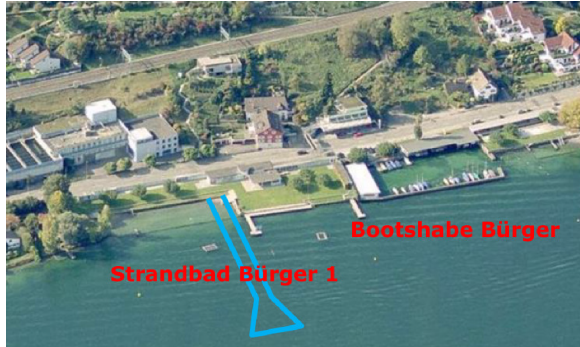
Figure 4. Situation at the lake site (outlet structure in blue)